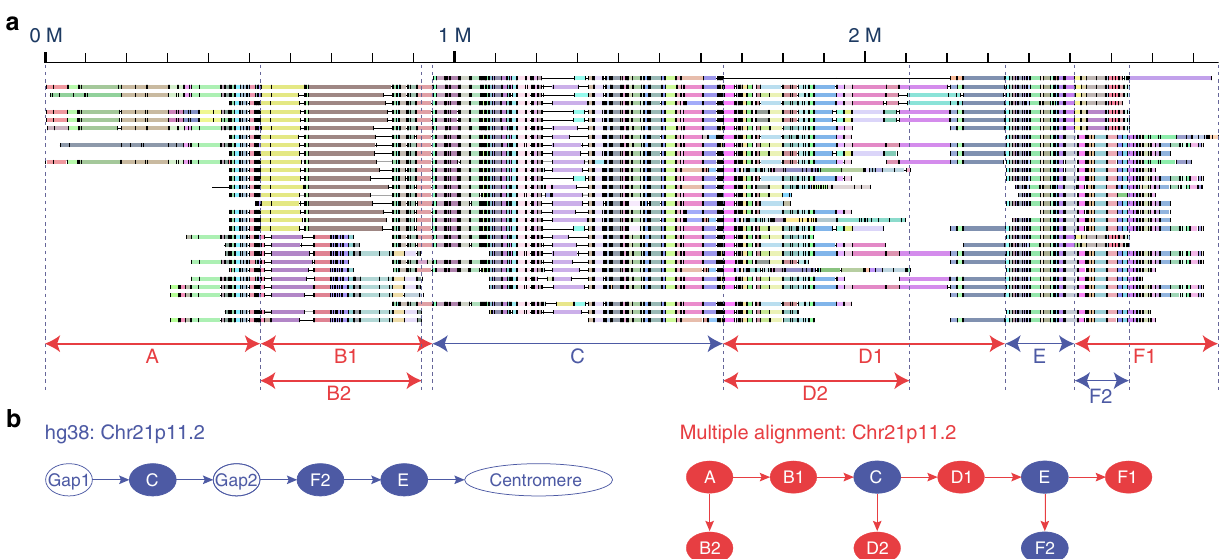
Fig. 5 Characterization and extension of chromosome 21p11.2 by multiple alignment. a Multiple alignment of selected contigs at 21p11.2. Red and blue arrows below indicate the subregions with patterns absent and present in chr21 of hg38, respectively. b The genome structures of hg38 (left) and the proposed new structure based on multiple alignment (right). The genome structure is represented as a fl ow chart of signal patterns where red and blue nodes represent patterns absent and present in chr21 of hg38,